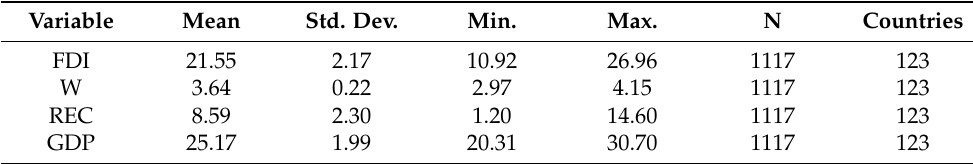
Table 1. Descriptive Statistics of the Concerned